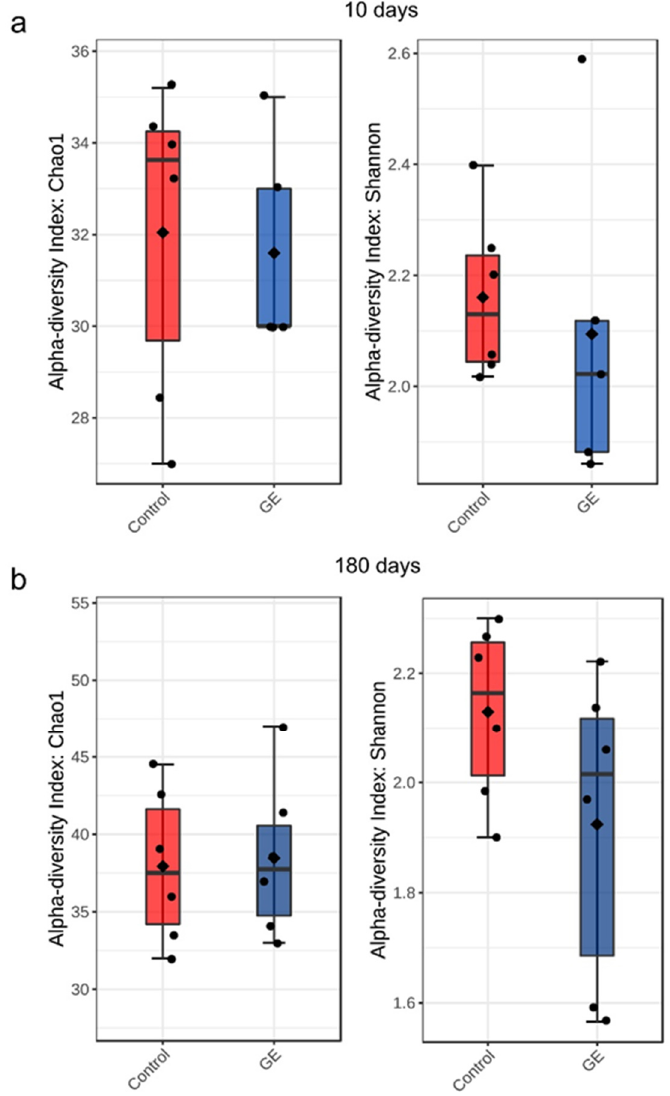
Figure 5. Boxplots illustrating differences in Chao1 and Shannon diversity measures of the fungal communities between treated × untreated plants: ( a ) 10 days after treatment; ( b ) 180 days after treatment; GE—treated plants; Control—untreated plants.